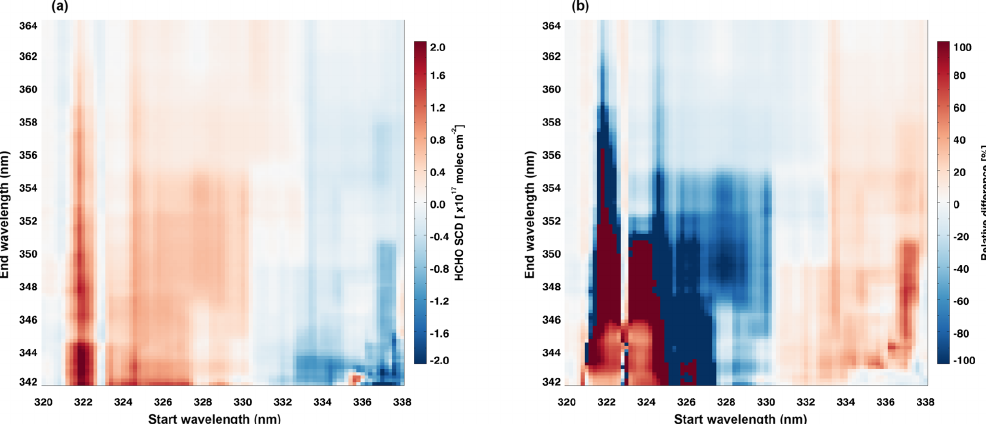
Figure 3. Color-coded means of (a) HCHO SCDs and (b) relative difference between BrO SCDs retrieved including the HCHO absorption cross section and those without HCHO for the Arctic BrO measurement